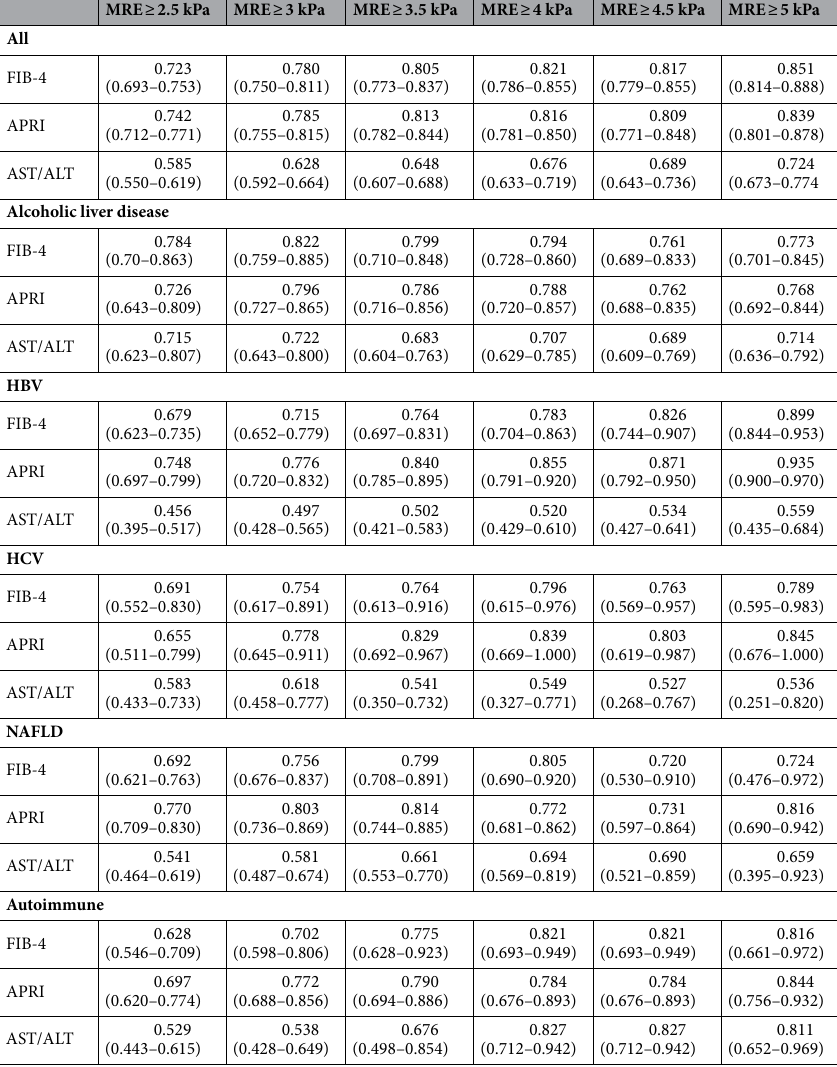
Table 2. AUROC of non-invasive hepatic fibrosis score according to various MRE cutoffs. AUROC area under the receiver operating characteristic; Values in parentheses are 95% confidence interval.